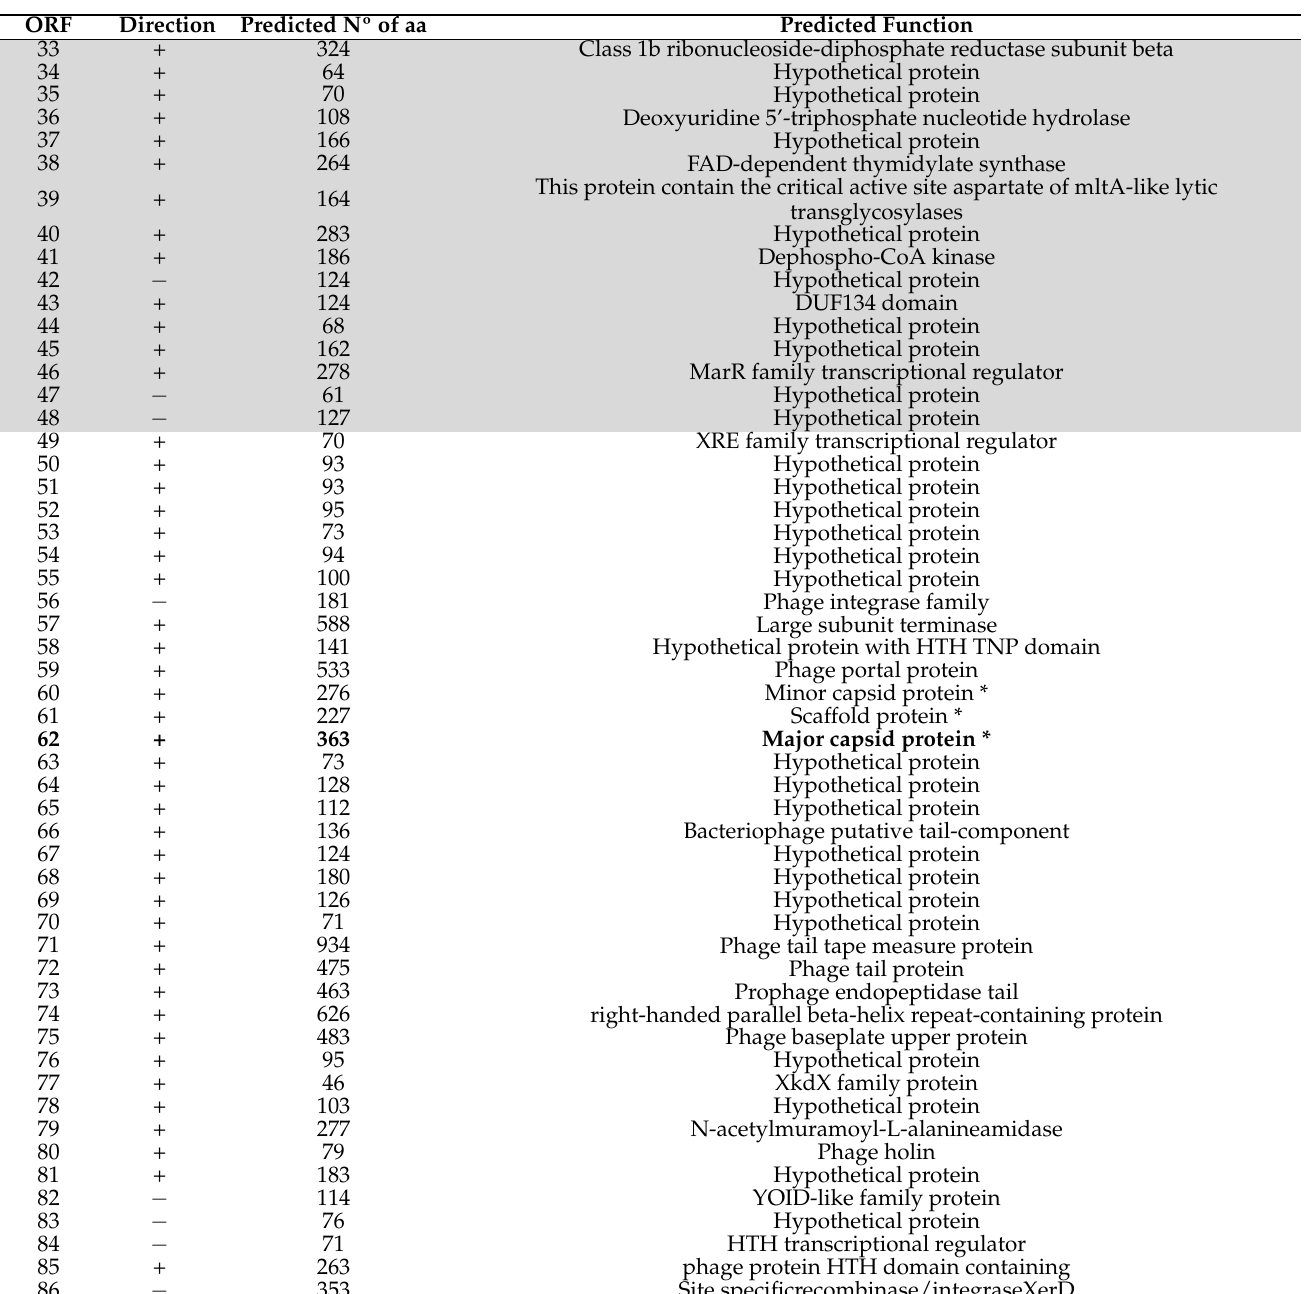
Site specificrecombinase/integraseXerD * Function predicted by PHASTER. +/ − Indicate Forward/Backward direction of transcription, respectively. The 31.5 Kb subregion (shadowed) and 28.7 Kb subregion (not shadowed) are indicated in the table. The protein found in fingerprinting analysis is shown in bold. A close analysis of the 60.2 Kb region shows that the predicted ORFs can be grouped into two subregions according to their putative function. This separation does not imply that they have different origin, and it was only made for description purposes. The 5 ´ end of the 60.2 Kb region (ORF 1 to 48; Table 3 shadowed in light grey; named subregion 1) of approximately 31.5 Kb, contained around 20 ORFs, with known functions related to DNA replication, DNA regulation and DNA metabolism; specifically, a DNA polymerase I (ORF 21), a helicase (ORF 10), a DNA primase (ORF 11), a Holiday junction resolvase (ORF 25), and several genes involved in nucleotide metabolism (ORF 31 to 33, ORF 36, ORF 38) and transcriptional regulation (ORF 2, ORF 12, ORF 13 and ORF